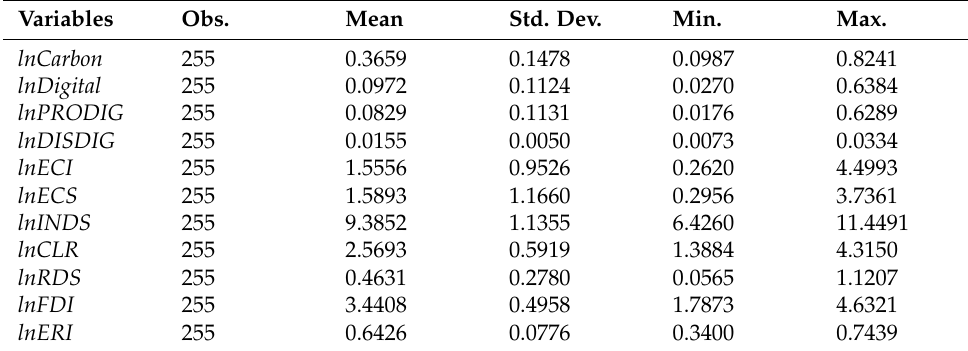
Table 4. Descriptive statistics of 11